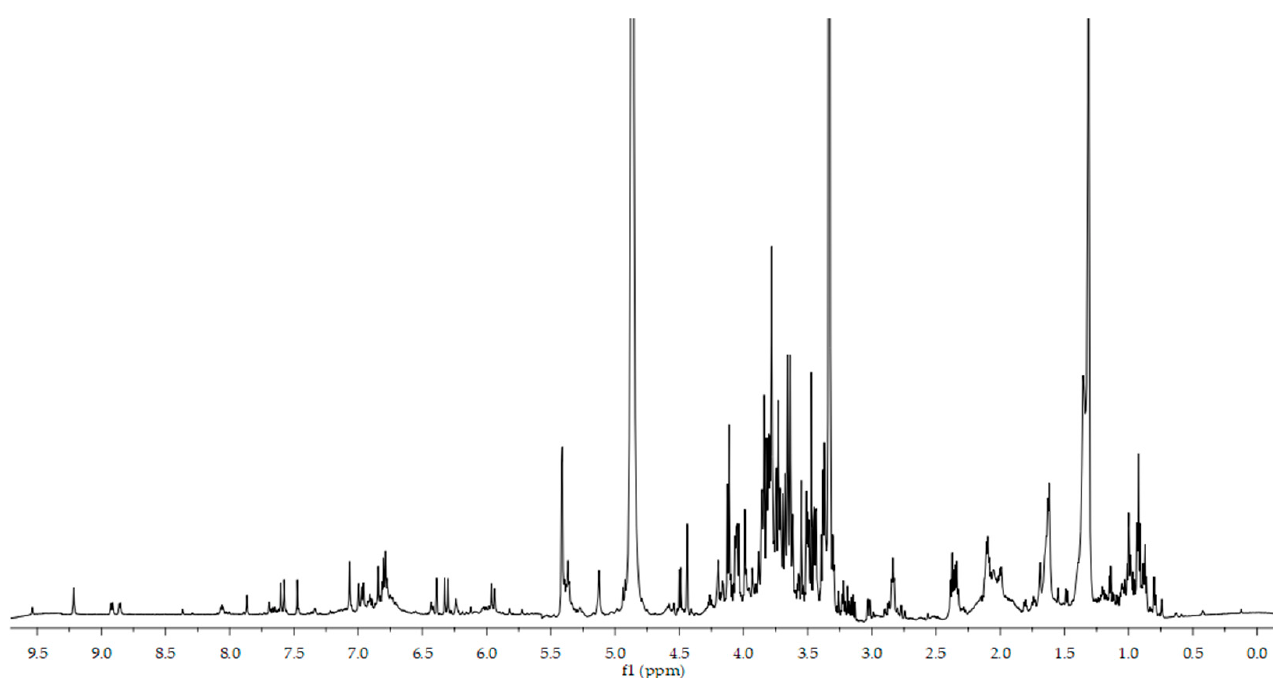
Figure 1. 1 H NMR (600 MHz) spectrum of Coffea arabica L. leaf extract resuspended in deuterated methanol. The assignment of the signals is reported in Figure 2 and the chemical shift values are reported in Table 2, together with the multiplicities and coupling constants. Table 2. Assignment of 1 H NMR signals in C. arabica L. leaf extracts.